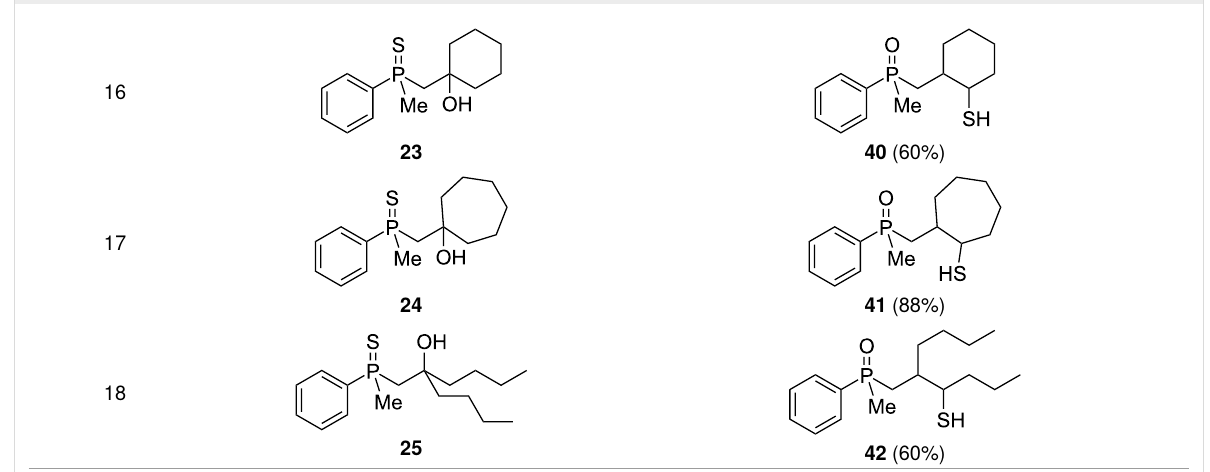
Table 2: Reaction of β -hydroxyalkylphosphine sulfides with Lewis-acidic AlCl 3 .